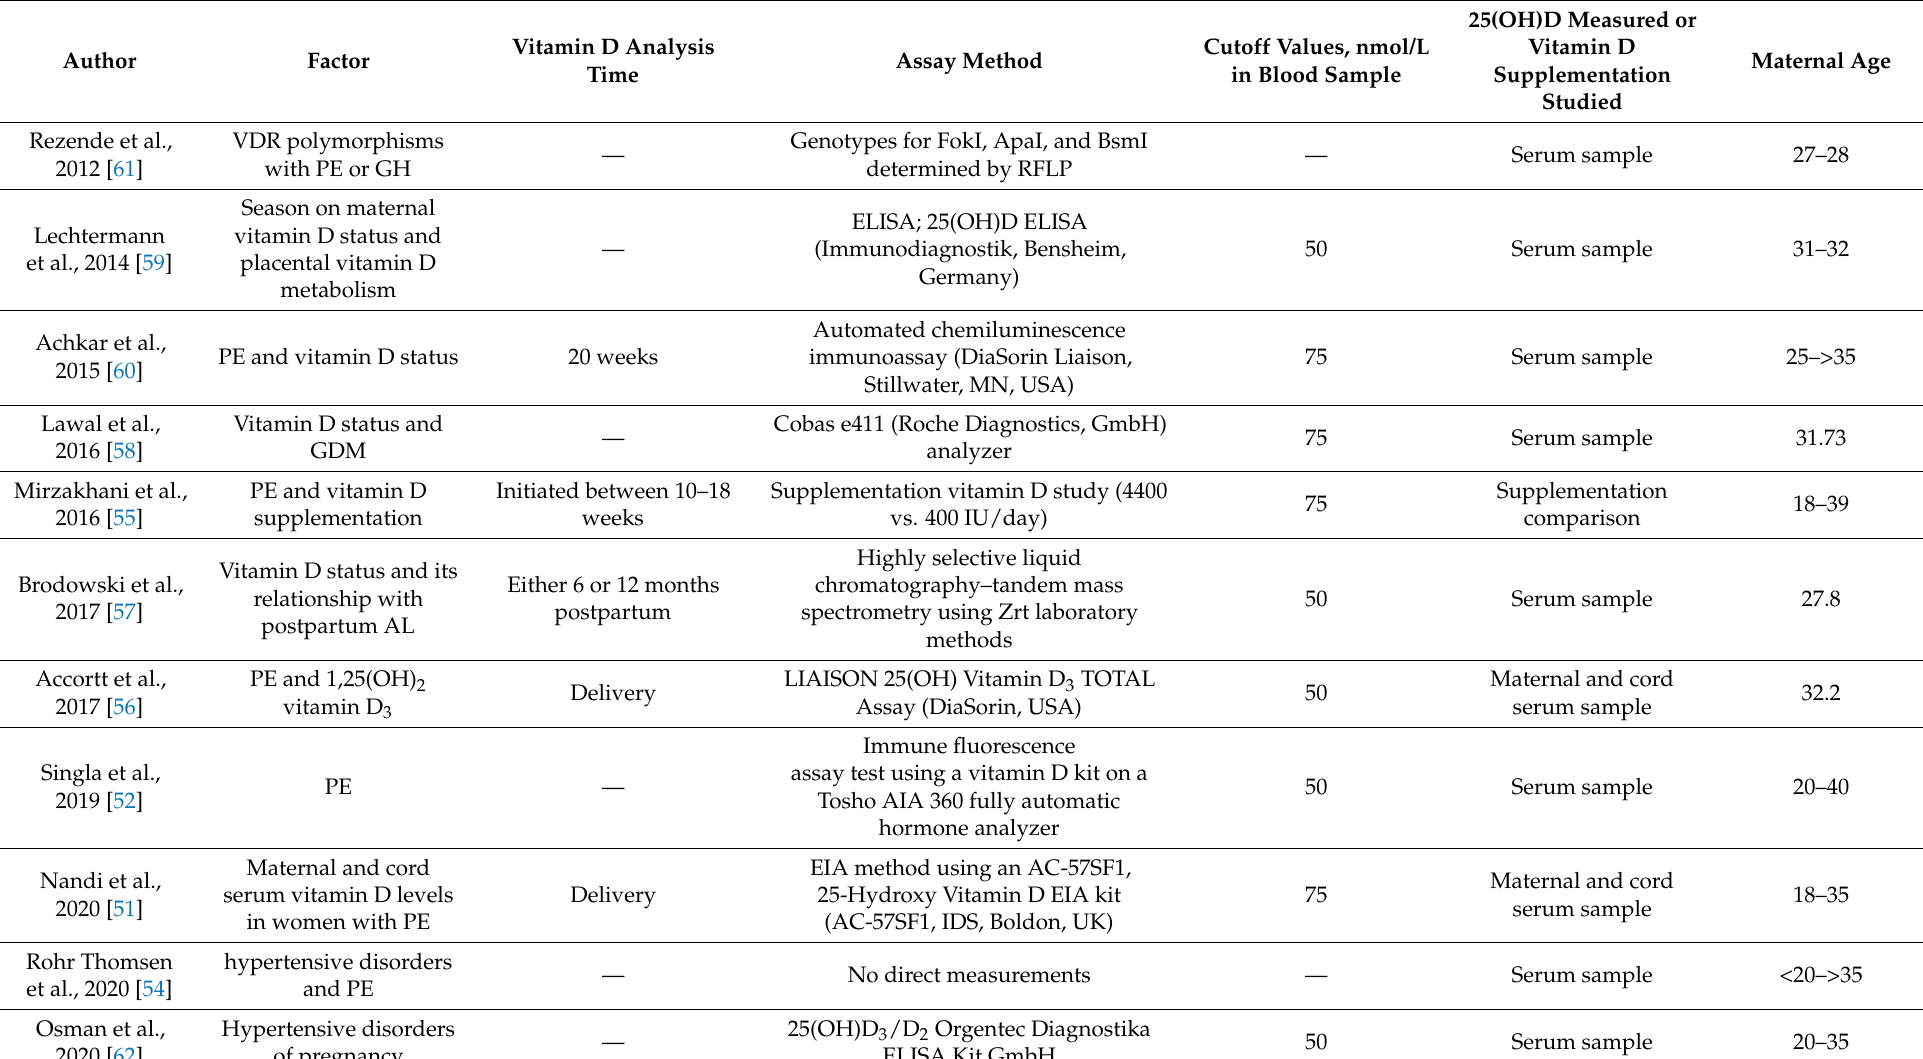
Table 2. Vitamin D-related information in original studies that show vitamin D-related risk factors for maternal morbidity during